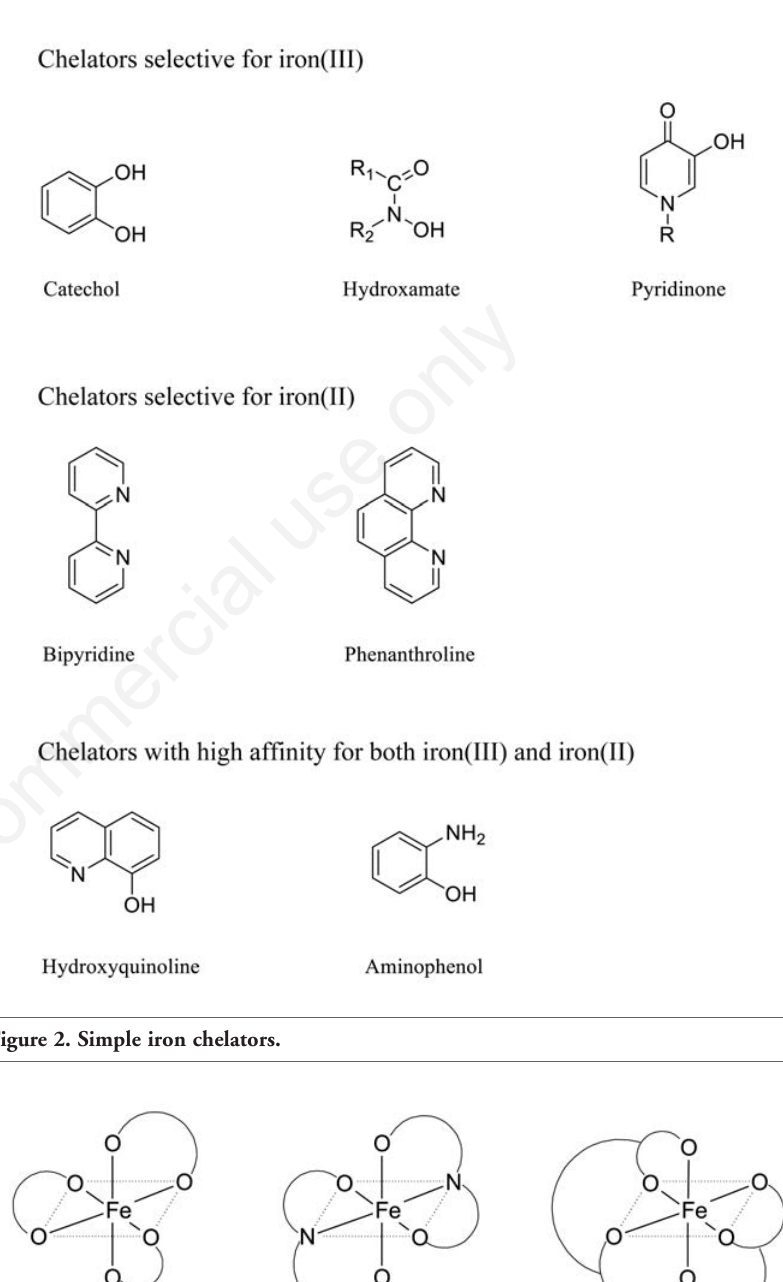
Figure 3. Schematic representation of chelate ring formation in metal-ligand